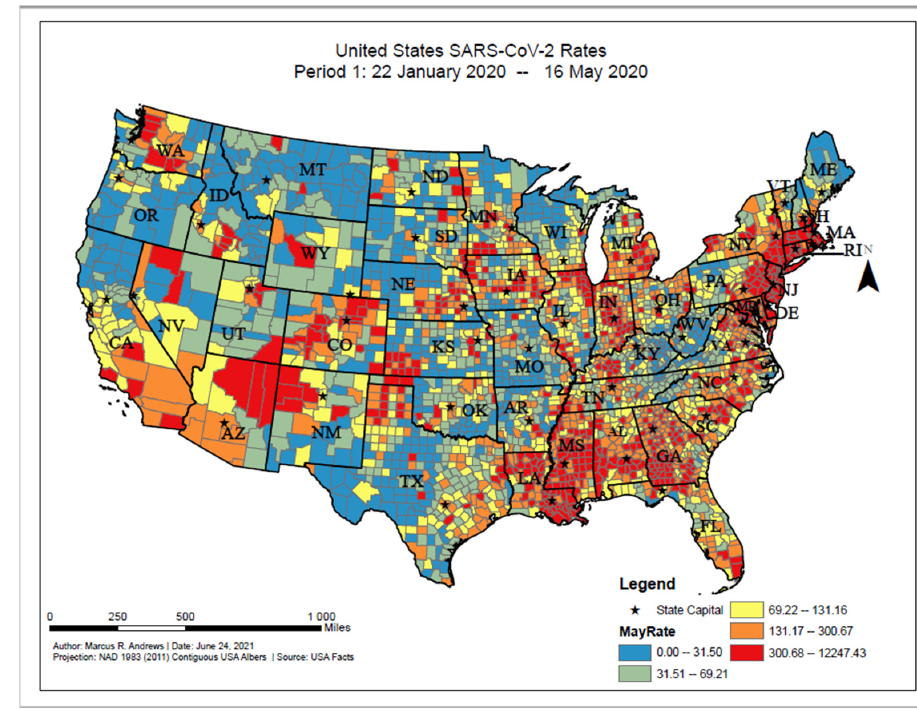
Figure 1. United States SARS-CoV-2 proportions, Period 1: 22 January 2020–16 May 2020.